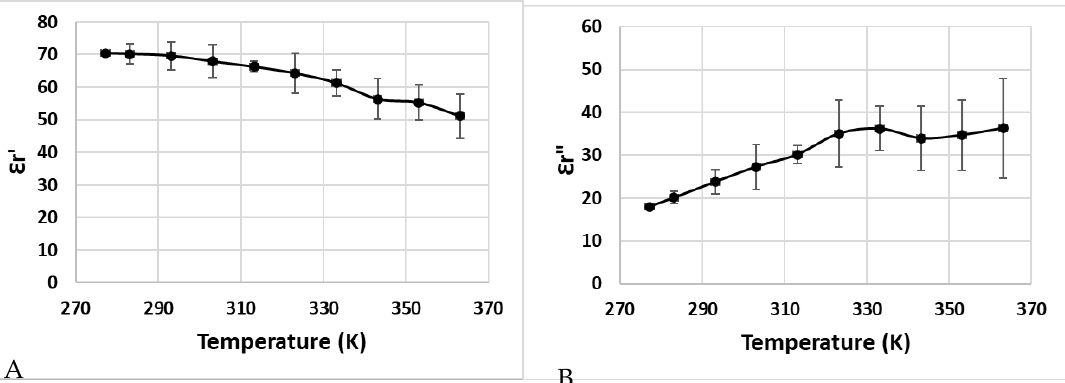
Figure 4. Dielectric properties of Cambodian pâté as a function of temperature at 915 MHz ( A ): measured value of Ԑ r ’ (T), ( B ): measured value of Ԑ r”(T)) .